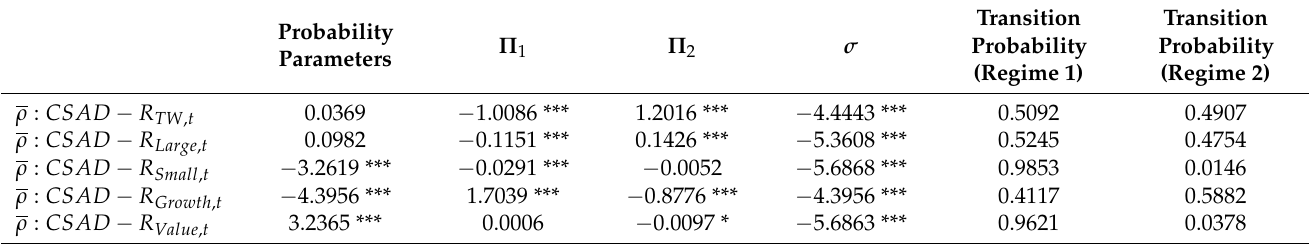
Table 5. The robustness results of the Markov regime-switching approach for beta-herding series.